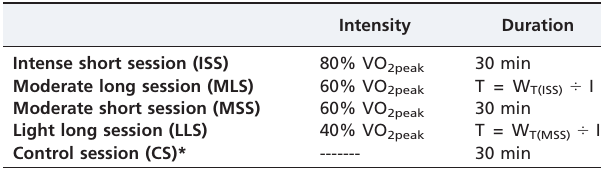
Table 1 - General characteristics of the sample. Variables